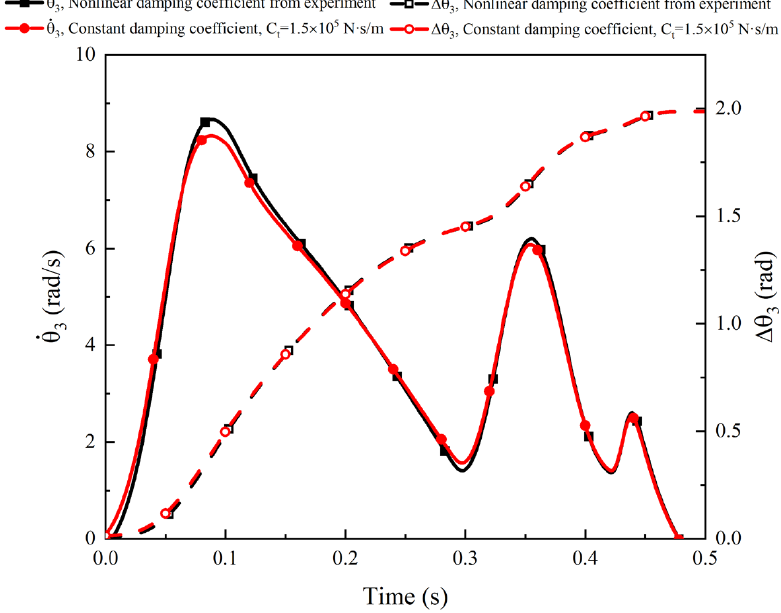
Figure 12. Comparison of the deployment angle and angular velocity between nonlinear C t and constant C t